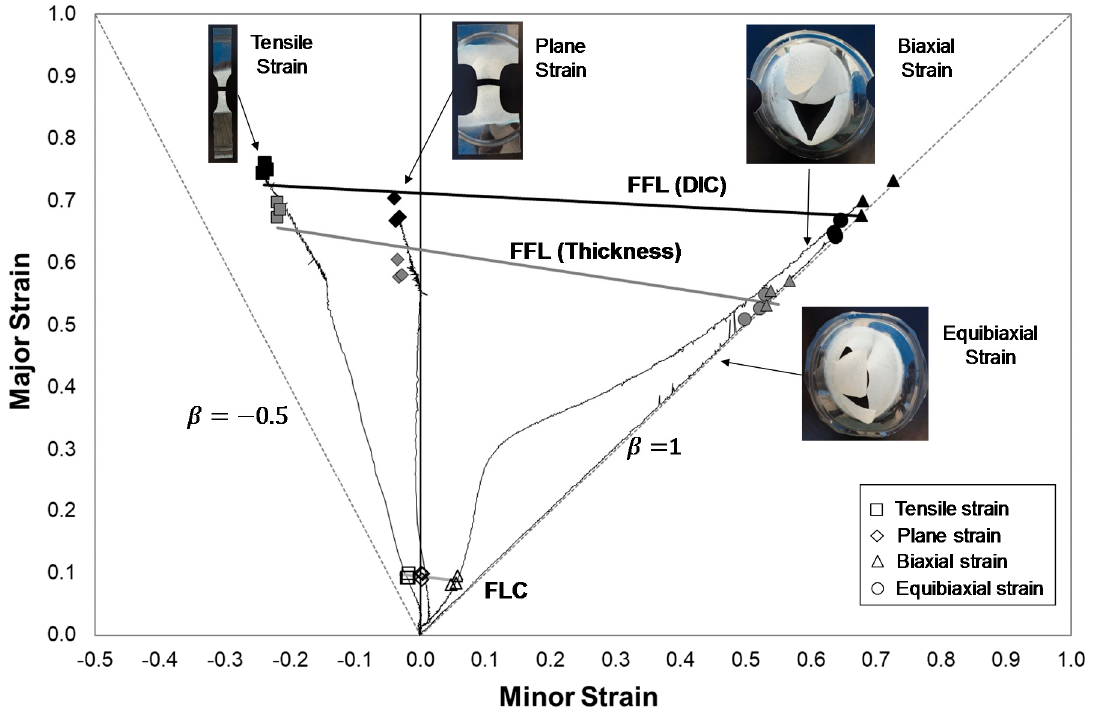
Figure 9. Formability limits by necking (FLC) and by Fracture (FFL) for PC sheets with 1 mm of thickness obtained by means of Nakajima specimens in the tensile, plane, biaxial and equibiaxial strain. The open markers correspond to failure strains by necking, the grey filled marker and black filled markers corresponds to failure strains by fracture obtained measuring the final thickness of the specimens and considering the last strain pairs of the DIC system, respectively.